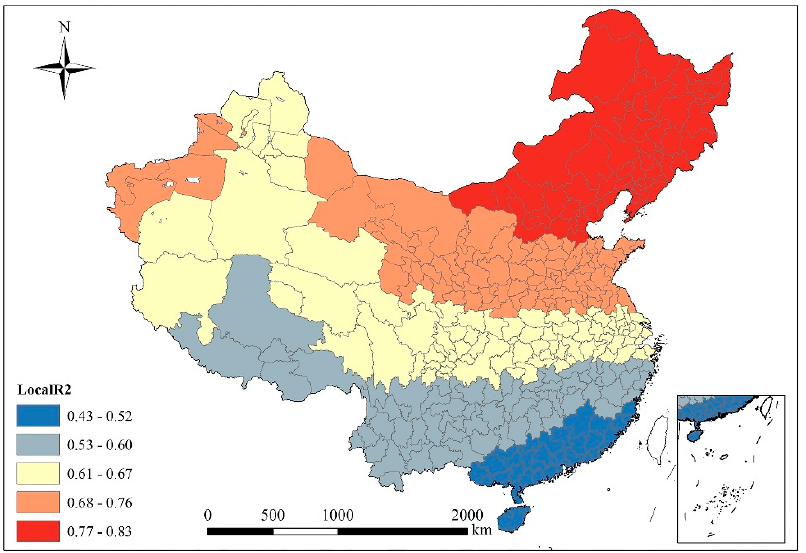
Figure 5. Local R 2 distribution characteristics according to geographically weighted regression (GWR) model.